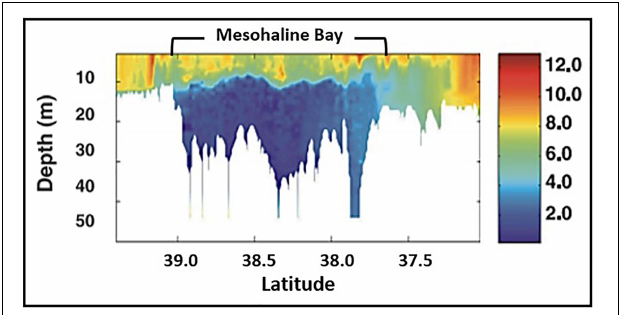
FIGURE 8 | Distribution of dissolved oxygen (mg liter − 1 ) along the main axis of Chesapeake Bay in summer, 2000 (modified from Costantini et al.,